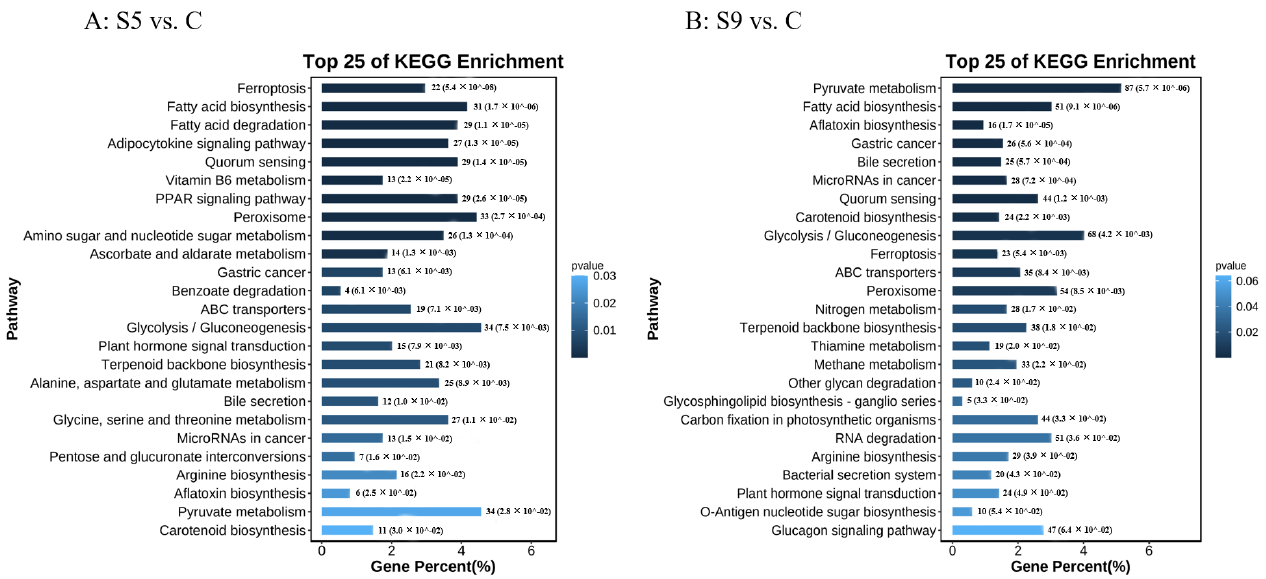
Figure 4. Top 25 pathways in the KEGG enrichment analysis of DEGs in S5 vs. C ( A ) and S9 vs. C ( B ). (C: salinity 30 psu; S5: salinity 50 psu; S9: salinity 90 psu.)